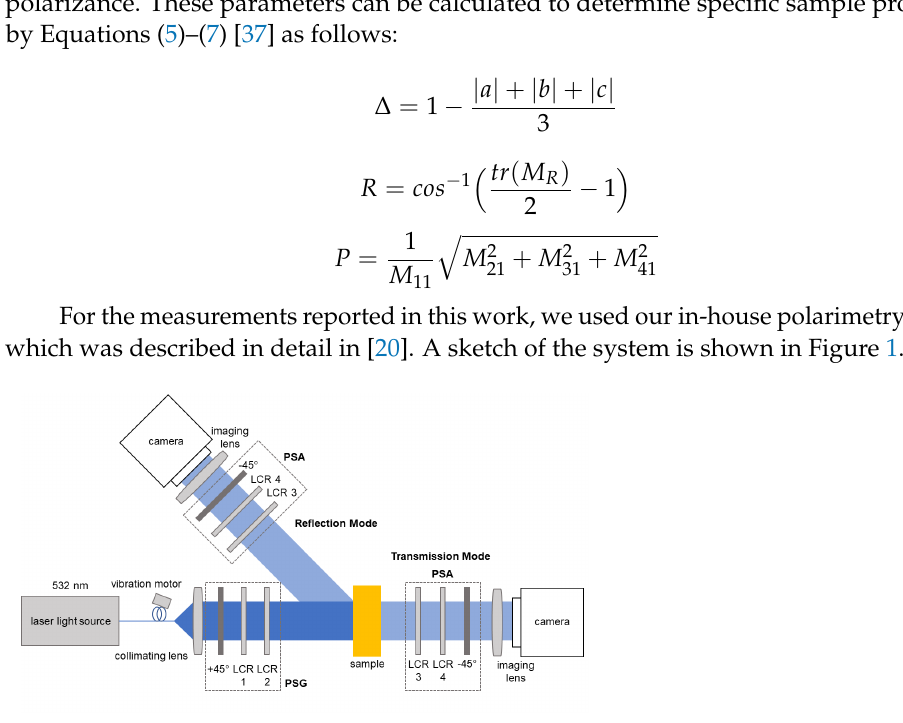
Figure 1. Sketch of the Mueller matrix polarimetry system. The light from the laser passes through the polarization state generator (PSG) which consists of two liquid crystal retarders (LCR) and a linear polarizer. After the interaction with the sample, the polarization states were analyzed by the polarization state analyzer (PSA) which also consists of LCRs and a linear polarizer. The LCR pairs are placed at different angles with respect to their principal